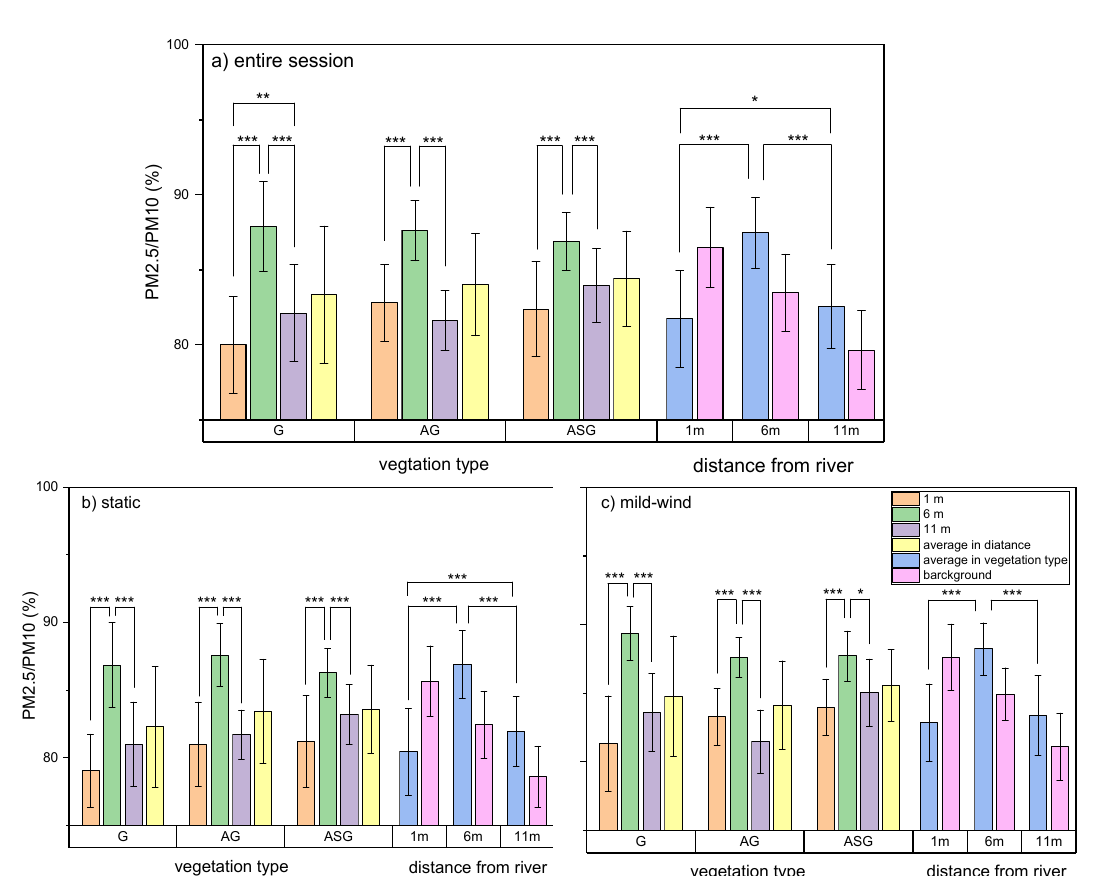
Figure 8. ANOVA results of the PM 2.5 /PM 10 ratio in different vegetation types and distances: ( a ) during the entire observation period, ( b ) under static conditions, and ( c ) under mild-wind conditions. * p ≤ 0.05 ** p ≤ 0.01 *** p ≤ 0.001. Error bar: standard deviation; G: open grassland; AG: arbor-grass woodland; ASG: arbor-shrub-grass woodland.